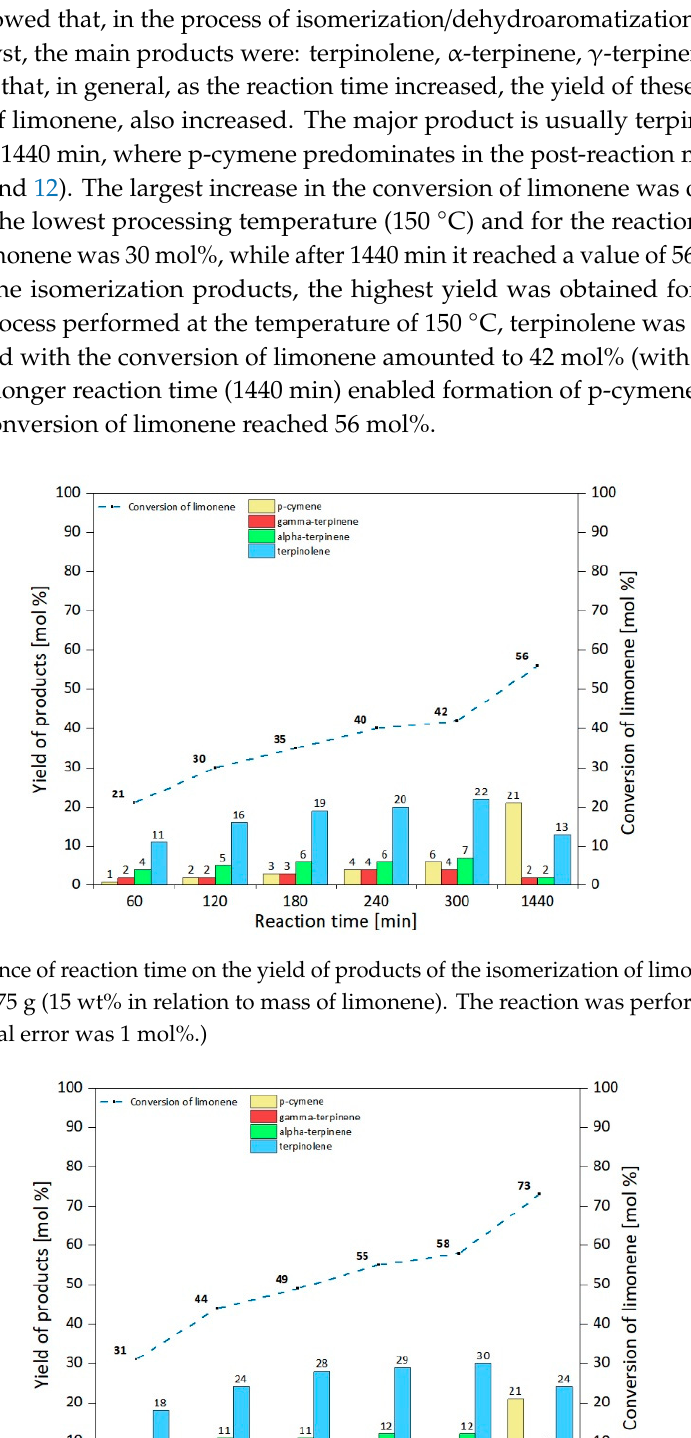
Figure 11. Influence of reaction time on the yield of products of the isomerization of limonene at 160 ◦ C. Amount of the catalyst 0.75 g, which is 15 wt% in relation to mass of limonene. (The experimental error was 1